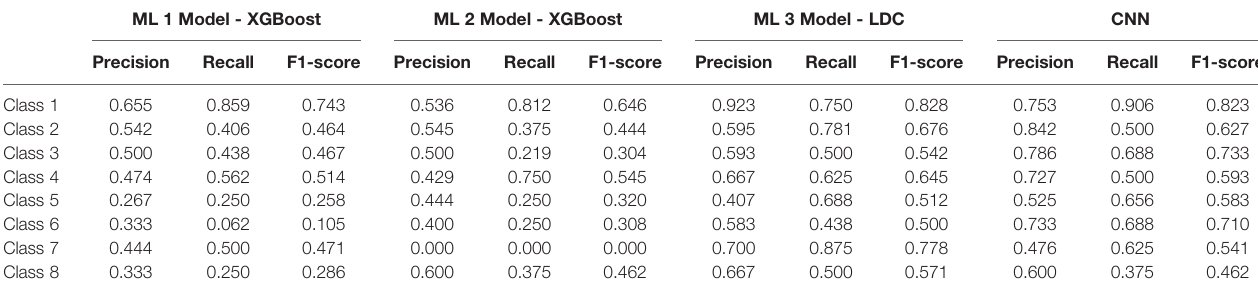
TABLE 3 | Precision, recall, and f1-score of ML 1 model-XGBoost, ML 2 model-XGBoost, ML 3 model-LDC, and CNN in type 3 classi fi cation.